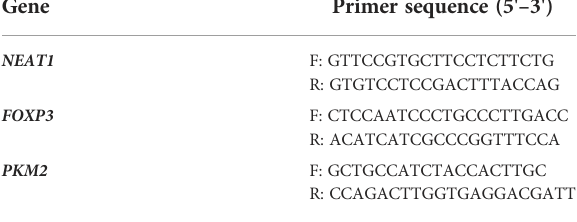
TABLE 1 qRT-PCR